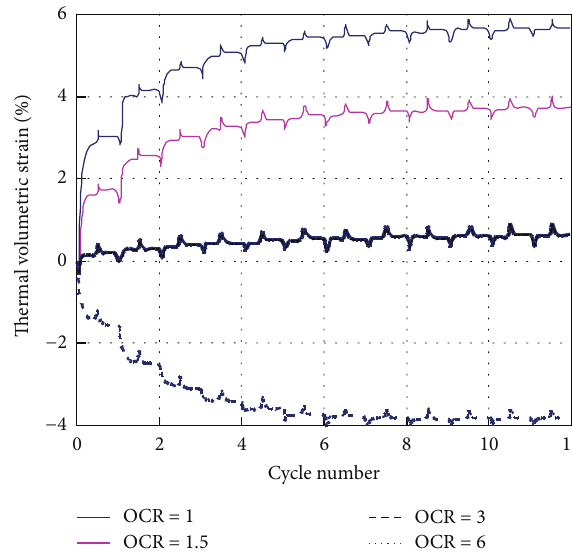
Figure 7: Thermal volumetric strain responses of silty clays with different OCR values under repeated thermal